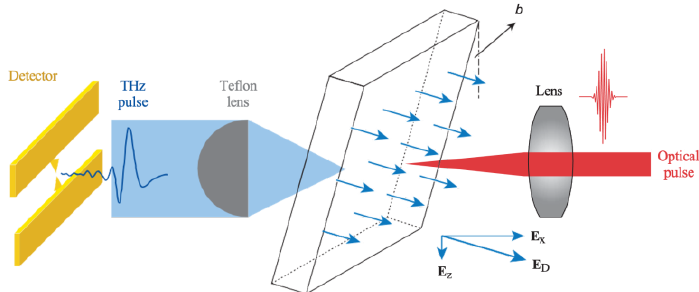
Figure 3. Variation in the basic experimental geometry with the sample tilted by an angle β with respect to the z -axis. The built-in E D field is no longer aligned along the x -axis, so it has a projection E z that can be captured by the PC THz detector.